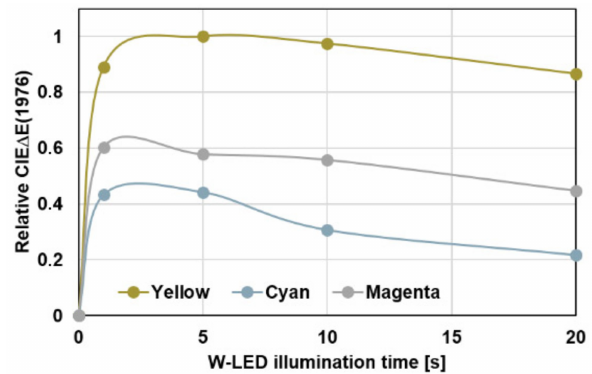
Figure 8. Colorization of C, M and Y VIS-trigger-able photochromic printing layers as a function of the illumination duration using the white light LED (W-LED) light source of the Samsung S4 mini smartphone device.